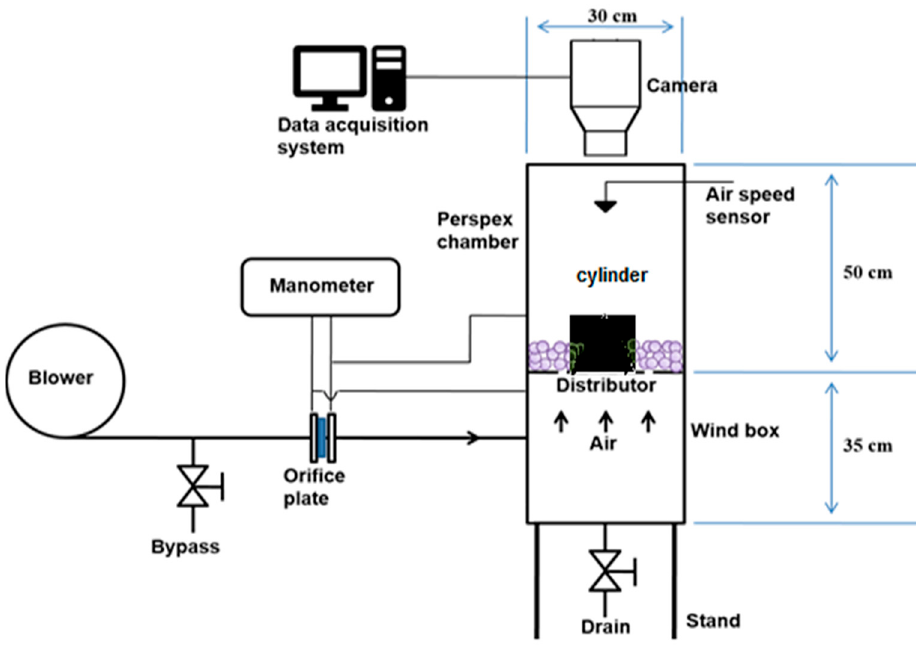
Figure 2. Schematic of a laboratory-scale swirling fluidized bed (SFB) operated with a mesh-coupled annular distributor.